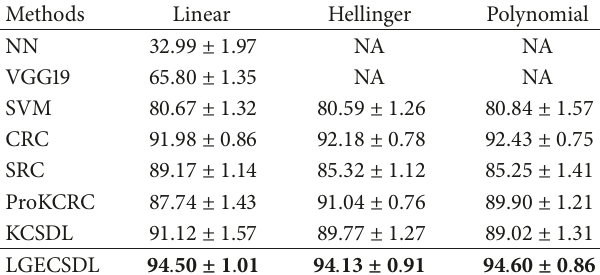
Table 2: Recognition rate on the AR database (%).